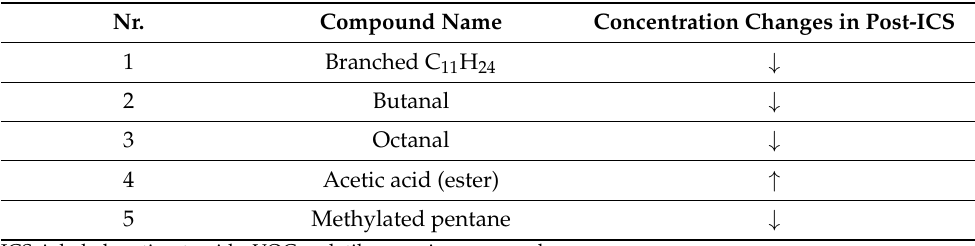
Table 2. Putative identification of the top 5 volatile organic compounds contributing to differentiation of individuals before and after treatment with ICS. ↓ indicates reduced level of a VOC in post-ICS individuals in reference to pre-ICS; ↑ indicates increased level of a VOC in post-ICS individuals in reference to pre-ICS. Nr. Compound Name Concentration Changes in Post-ICS 1 Branched C 11 H 24 ↓ 2 Butanal ↓ 3 Octanal ↓ 4 Acetic acid (ester) ↑ 5 Methylated pentane